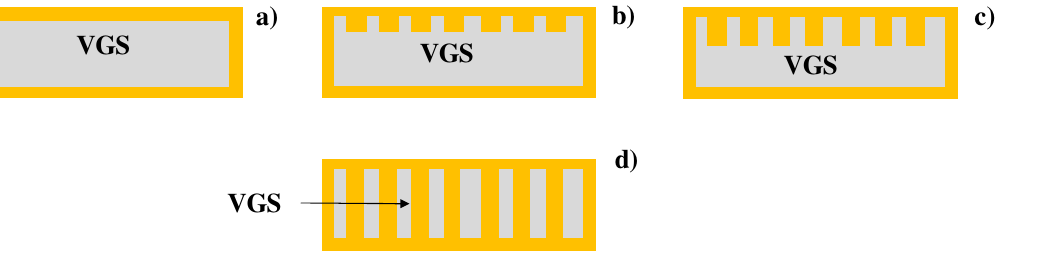
Figure 1. Four VGS packaging designs with copper coverage. ( a ) Simply copper-covered VGS, ( b , c ) micro-textured VGS filled with copper coverage in shallow, and deep holes, respectively, and ( d ) composite VGS-copper